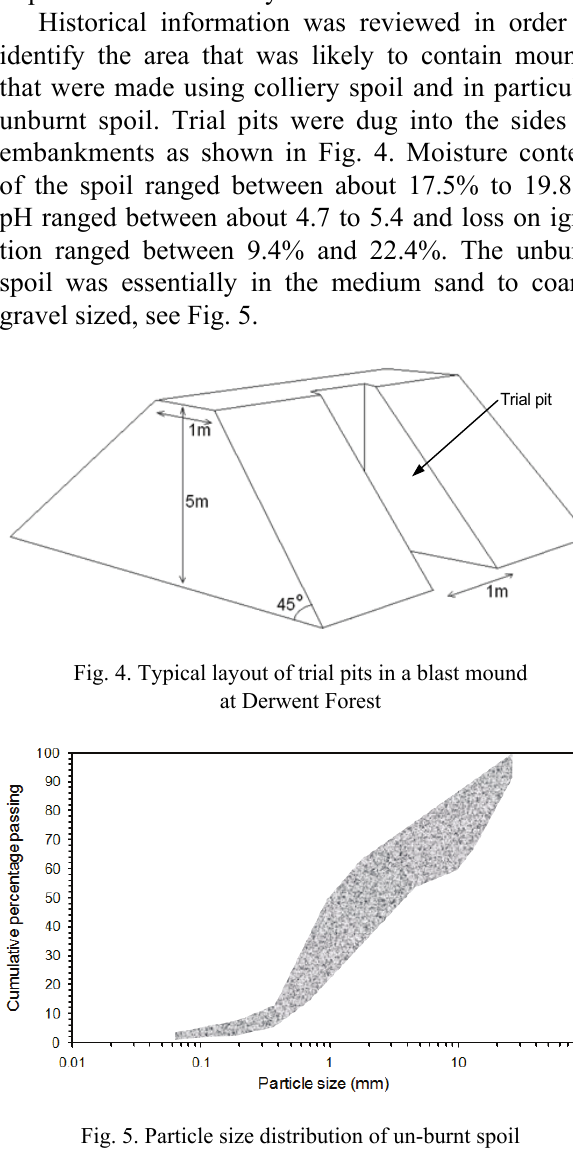
Fig. 5. Particle size distribution of un-burnt spoil from trial pits at Derwent